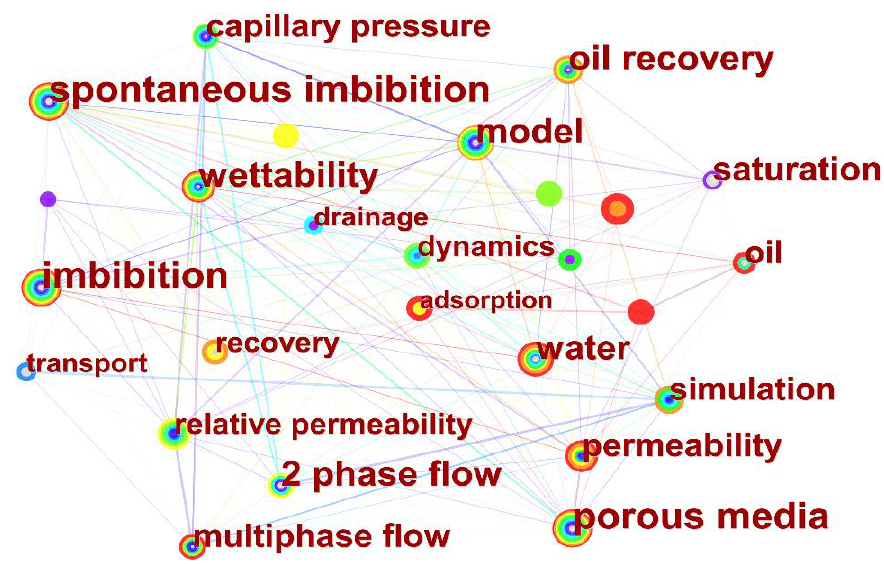
Figure 7. Keyword co-occurrence network.